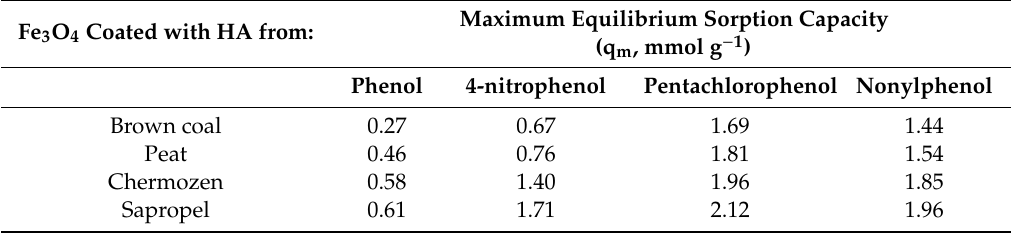
Table 9. Maximum equilibrium sorption capacities for the sorption onto Fe 3 O 4 nanoparticles coated with HA (average size = 105 nm, specific surface area = 61–77 m 2 g − 1 ) (adapted from [114]). Fe 3 O 4 Coated with HA